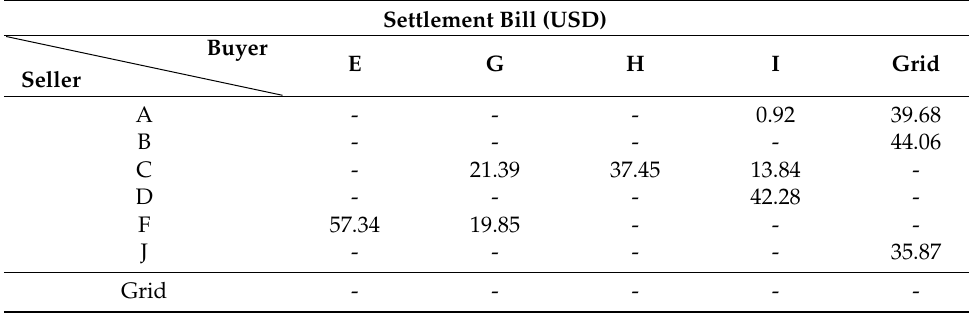
Table 12. The settlement bill after